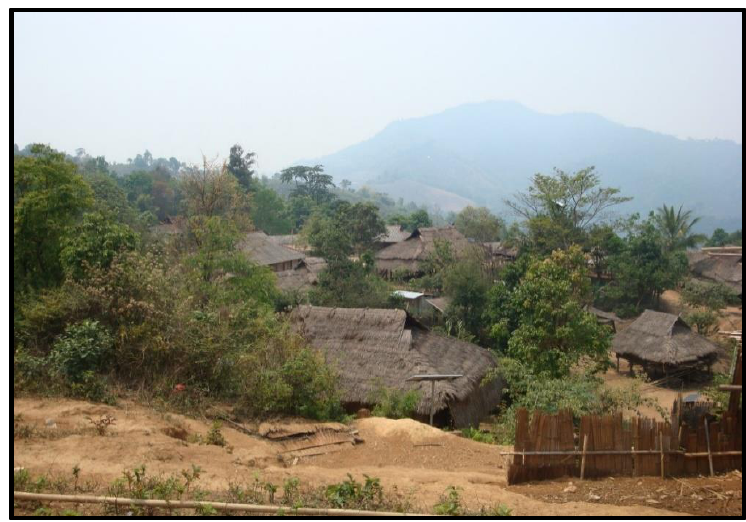
Figure 6. SHS in the Akha upland community. Source: produced by the authors (2017).